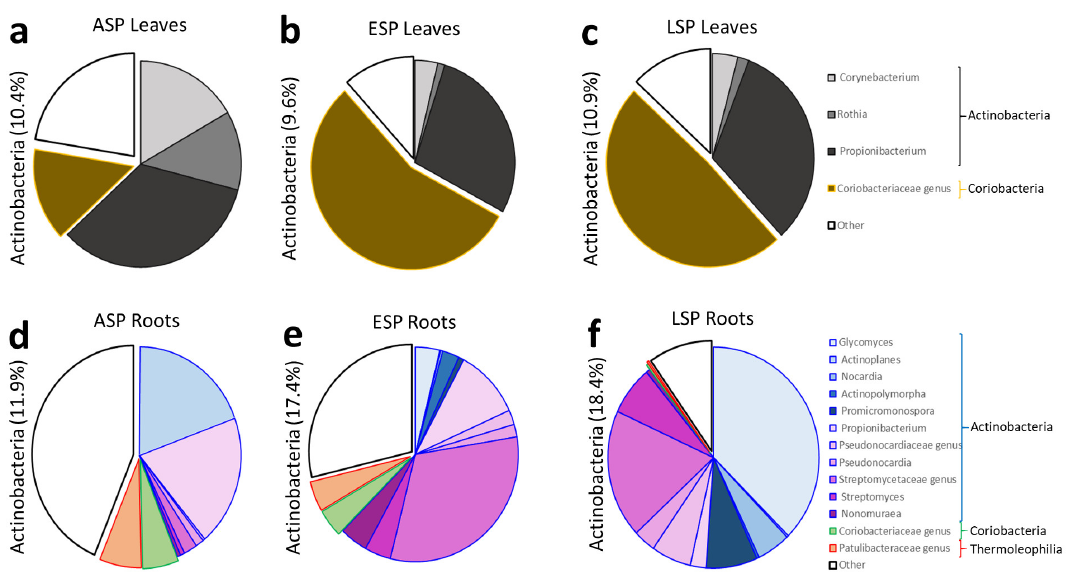
Figure 6. Pie graphs describing the relative abundance of genera in the Actinobacteria phylum . Between brackets is indicated the total share of the phylum , while each genus is represented by the size of the corresponding slice. ( a ) ASP leaves; ( b ) ESP leaves; ( c ) LSP leaves; ( d ) ASP roots; ( e ) ESP roots; ( f ) LSP roots.